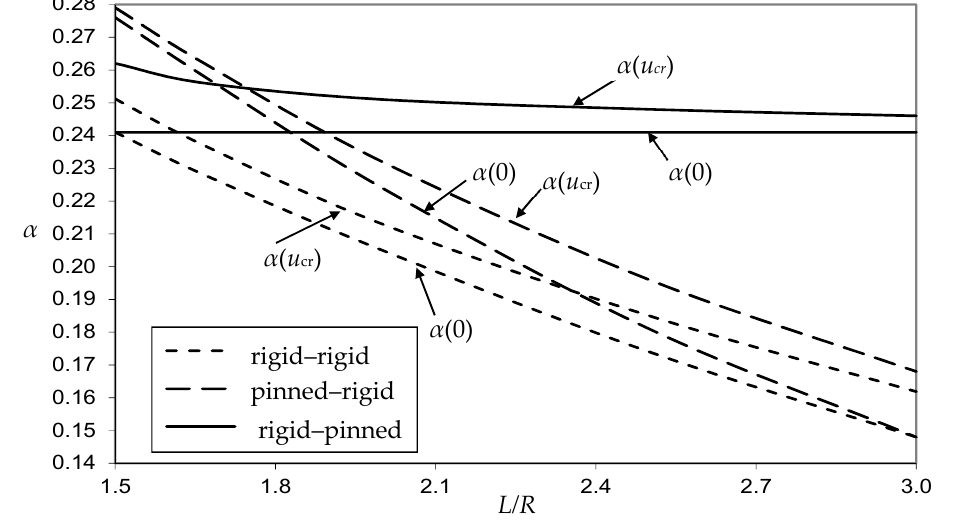
for the pinned–rigid connection